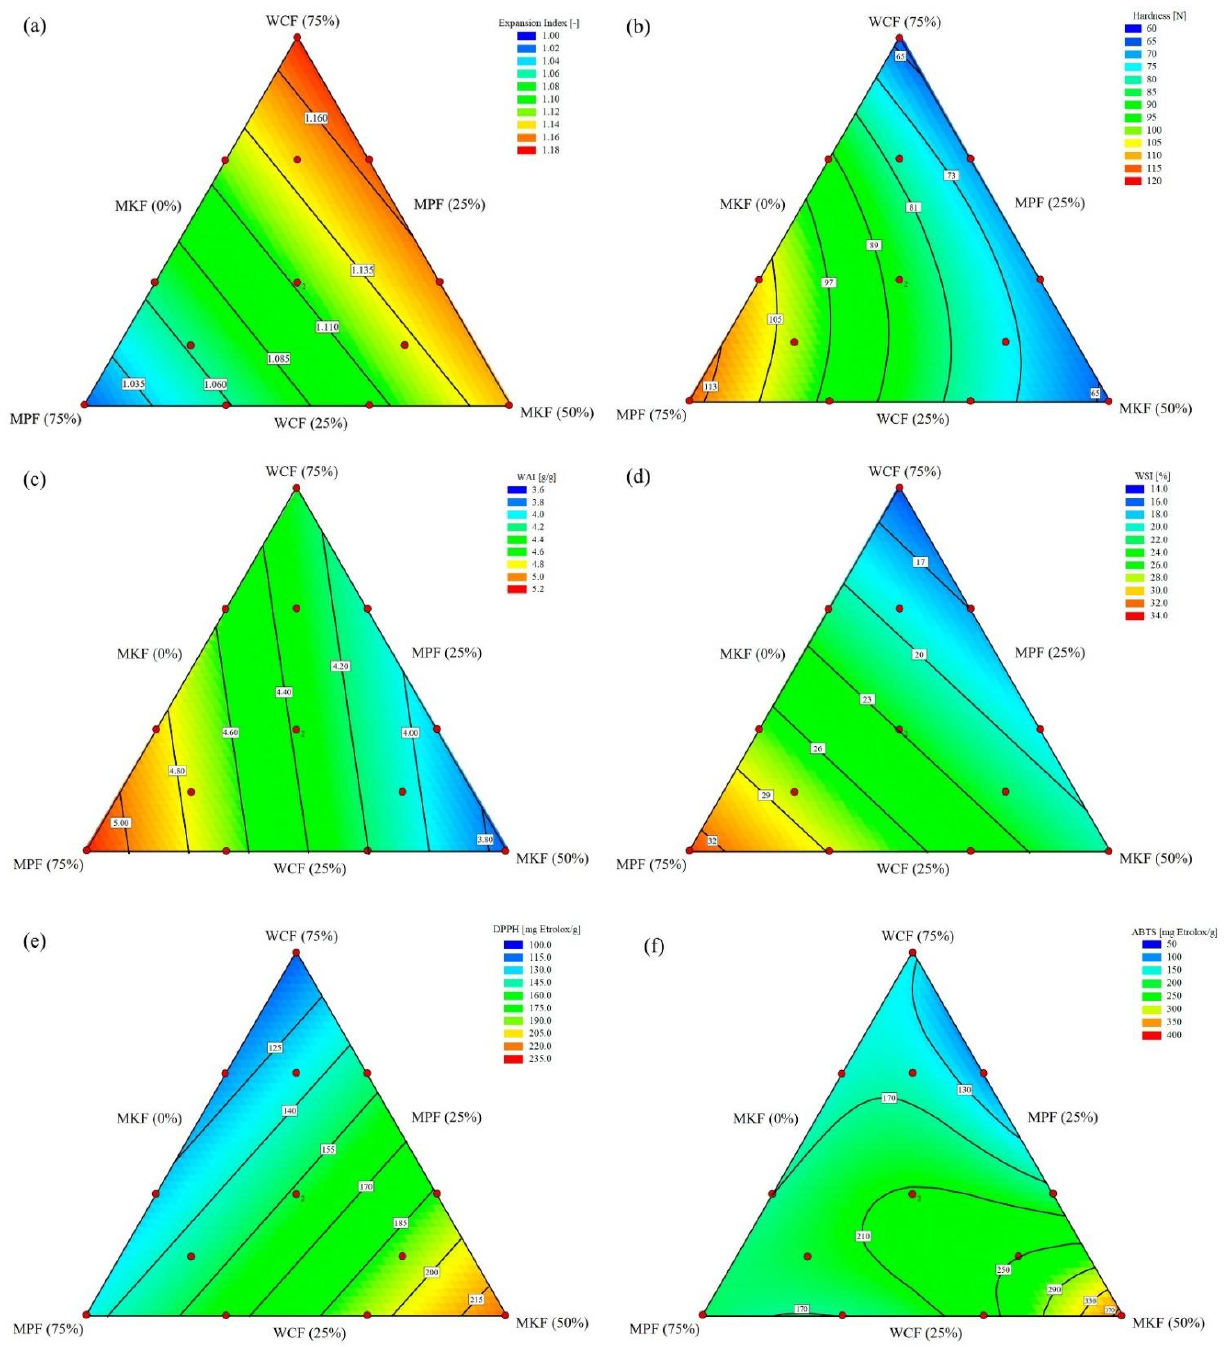
Figure 2. Estimated response of surface plots indicating effects of mixture design of white corn flour (WCF), mango peel flour (MPF) and mango kernel flour (MKF) on the physical and chemical properties of extrudate: ( a ) Expansion Index, ( b ) Hardness, ( c ) Water Absorption Index (WAI), ( d ) Water Solubility Index (WSI), ( e ) DPPH, ( f )